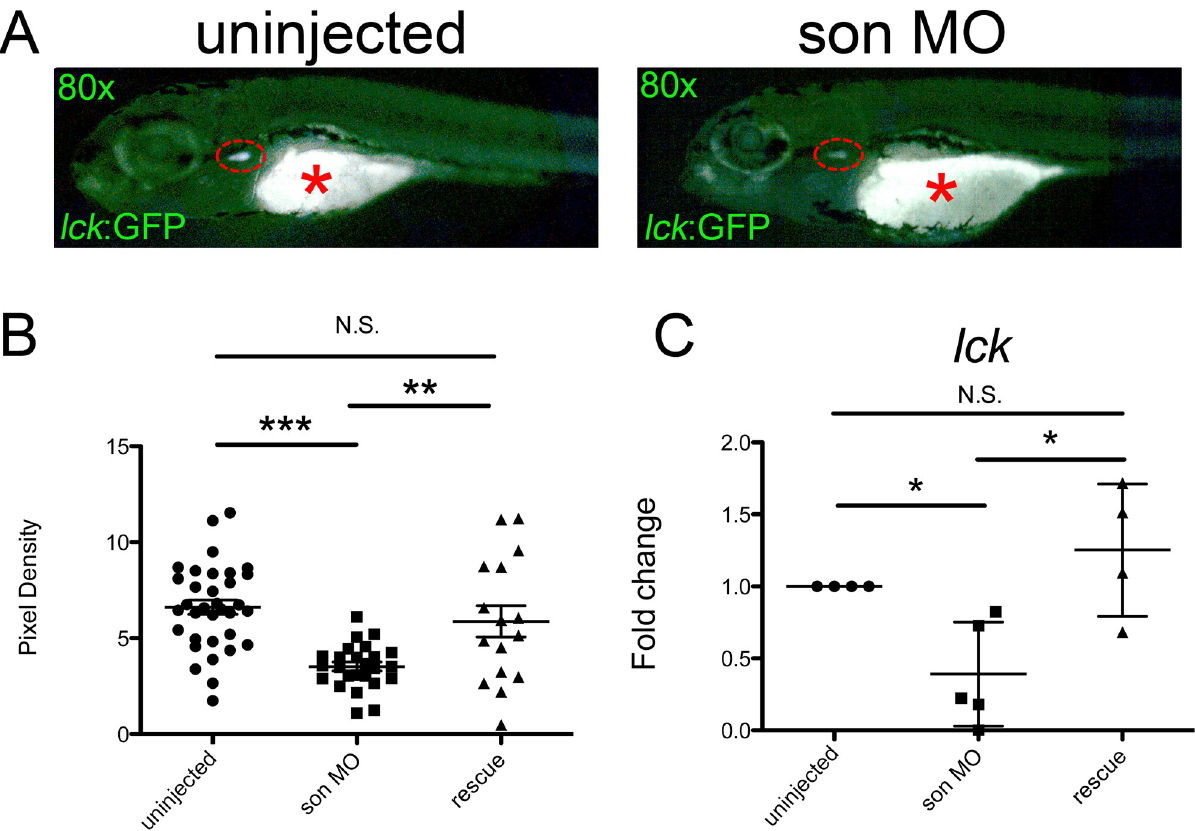
Fig 4. son reduction decreases T cell numbers. ( A ) Representative images of lck :GFP embryos at 5dpf that were uninjected (control; left) or injected with MO at the one-cell-stage of development ( son MO, right). Images were taken at 80x. Individual GFP + T cells are located in the thymi (red dashed oval); these cells are not circulating. � denotes background fluorescence present in the yolk ball due to refraction of light from lipids present in the yolk. ( B ) Images (like shown in A ) were subjected to analysis with ImageJ to determine the pixel density of uninjected, MO-injected ( son MO), or MO- injected with son RNA (rescue) thymi. ( C ) qRT-PCR for lck was performed. Each point represents ten embryos randomly selected from uninjected, MO-injected ( son MO), or MO-injected with son RNA (rescue) conditions that were analyzed by qRT-PCR. Middle lines represent mean and error bars represent SD. � represents p = 0.02, �� represents p = 0.01, ��� represents p < 0.001, N.S. represents no